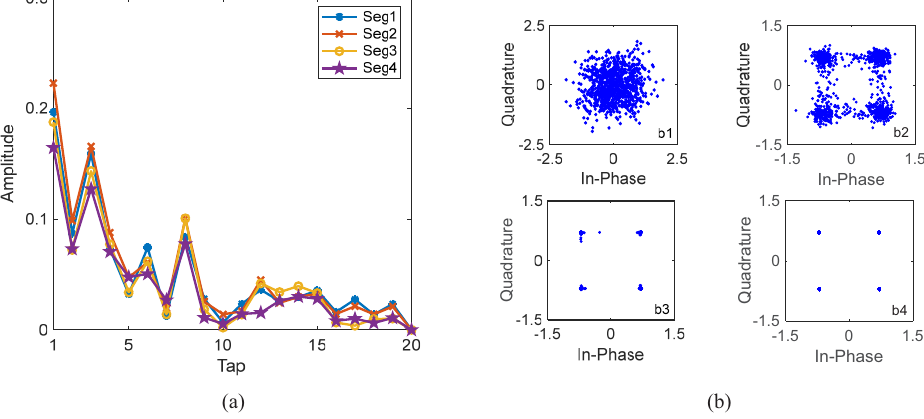
Figure 20. Estimated channels and equalization results of the fourth block with S256 and 1/2 code rate for Yellow Sea 2 in Figure 14. ( a ) The estimated channels of the consecutive four segments after 3 iterations; ( b1 ) constellations after 0 iteration; ( b2 ) constellations after 1 iteration; ( b3 ) constellations after 2 iterations; ( b4 ) constellations after 3